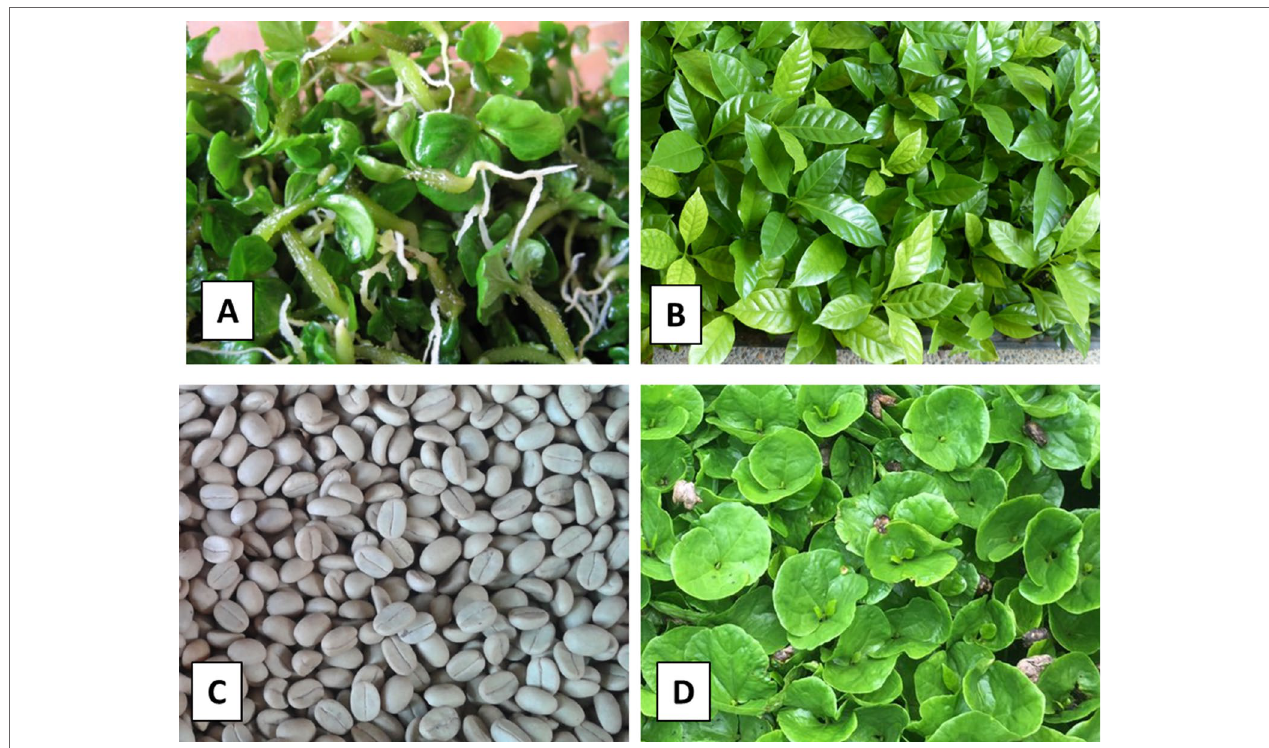
FIGURE 1 | Production of Starmaya F1 C. arabica hybrid. (A) Pre-germinated embryos of sterile-male CIR-SM01 produced by somatic embryogenesis. (B) Plantlets of sterile-male CIR-SM01 derived from somatic embryos and acclimatized in trays during 4 months. (C) Seeds of C. arabica Marsellesa ® variety. (D) 2-month-old plants of Marsellesa ® variety obtained after seed